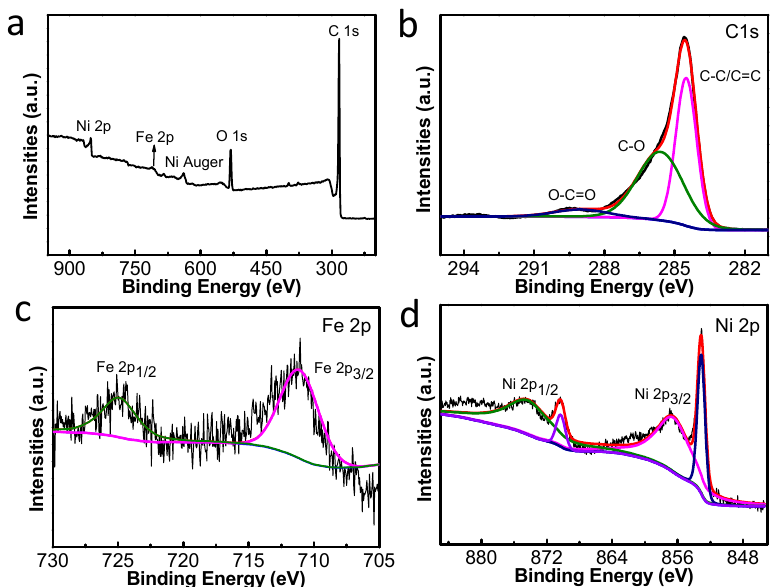
Figure 5. X-ray photoelectron spectroscopy (XPS) spectra of the sample of S2: ( a ) survey scan of FeNi 3 @C composites; ( b ) C 1s spectrum; ( c ) Fe 2p spectrum; ( d ) Ni 2p spectrum.